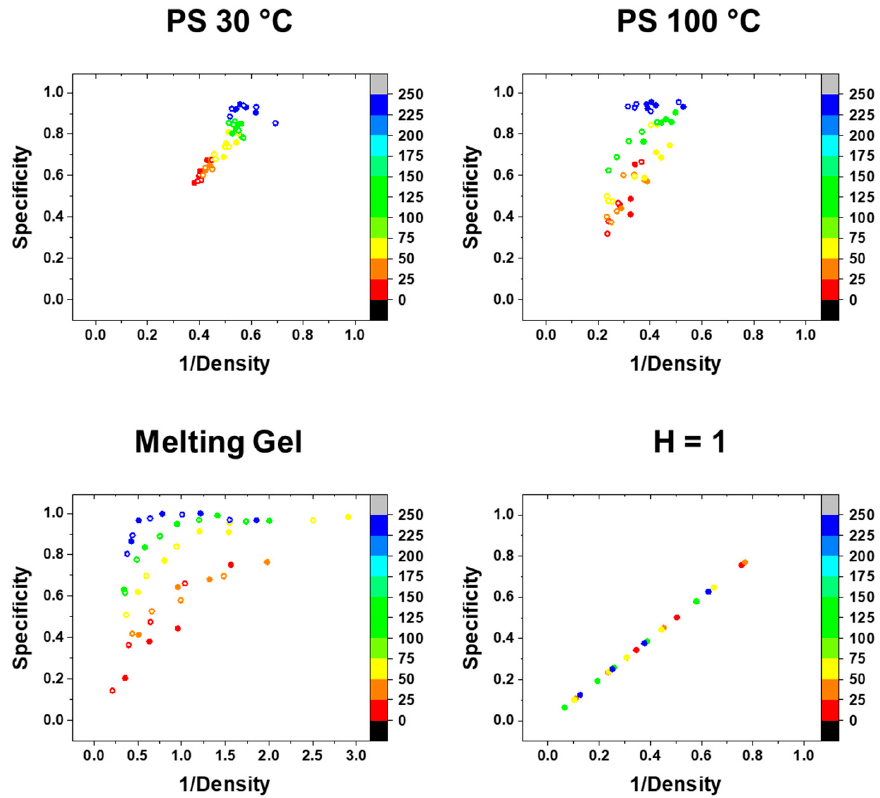
Figure 7. Specificity vs. 1/Density with color maps denoting feature size ( μ m).